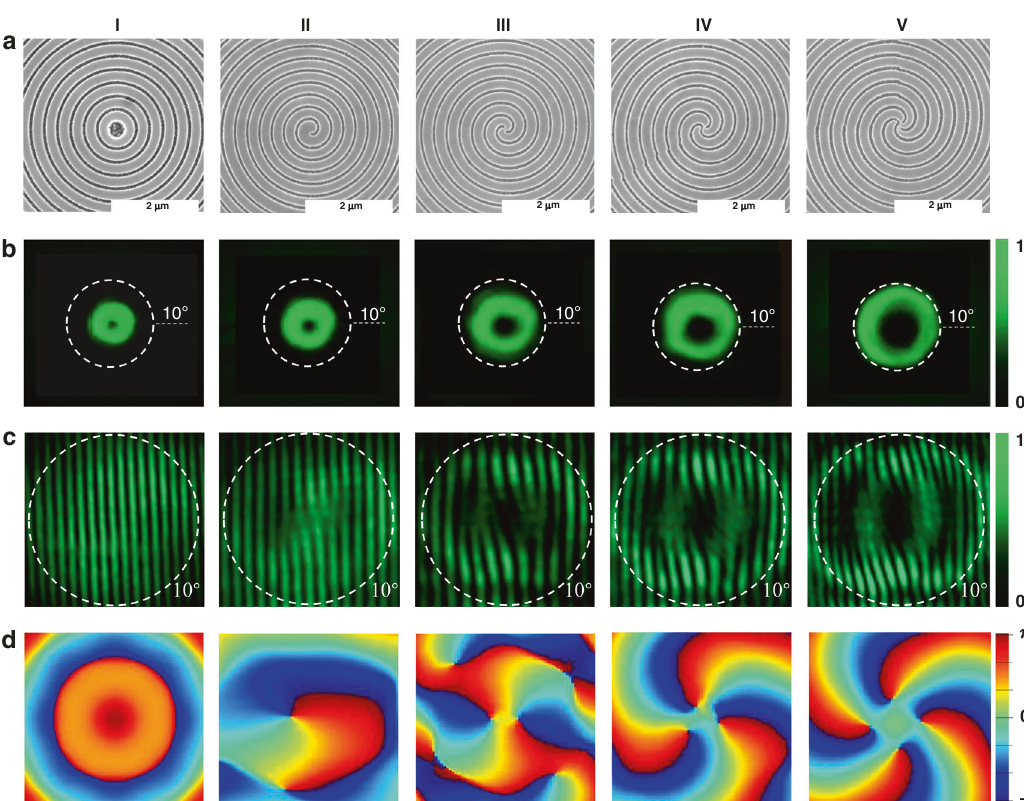
Fig. 5 The MAPbBr 3 perovskite VCSELs with different topological charges. a The top-view SEM images of the Archimedean spiral gratings with l = 0 (I), l = 1 (II), l = 2 (III), l = 3 (IV), and l = 4 (V). b The corresponding far fi eld beam pro fi les of the perovskite VCSELs. c The corresponding self-interference patterns of emission beams in the forward direction. Here, the pump fl uence is 21 µ J/cm 2 . d The corresponding phase distribution simulation results. The white lines represent the angle of